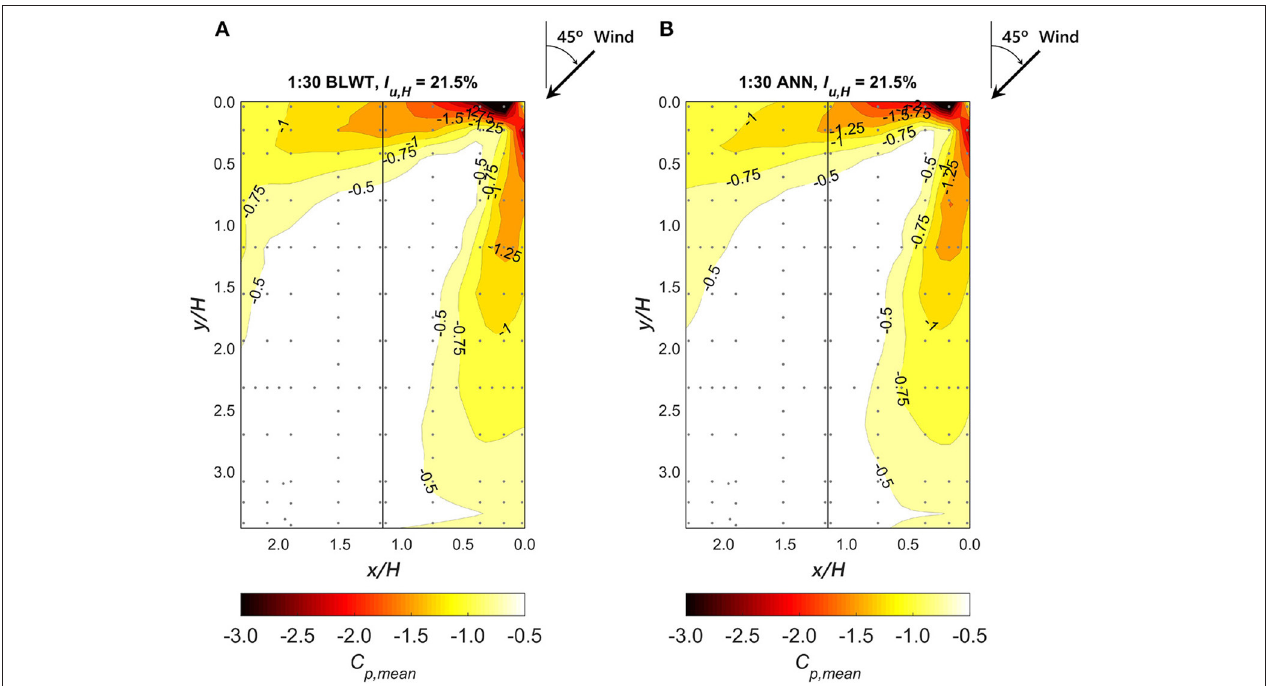
FIGURE 9 | Prediction of mean pressure coefficients ( C p , mean ) for the 1:30 WERFL model and a freestream turbulence intensity of 21.5% at eave height: (A) BLWT experimental data and (B) ANN prediction.